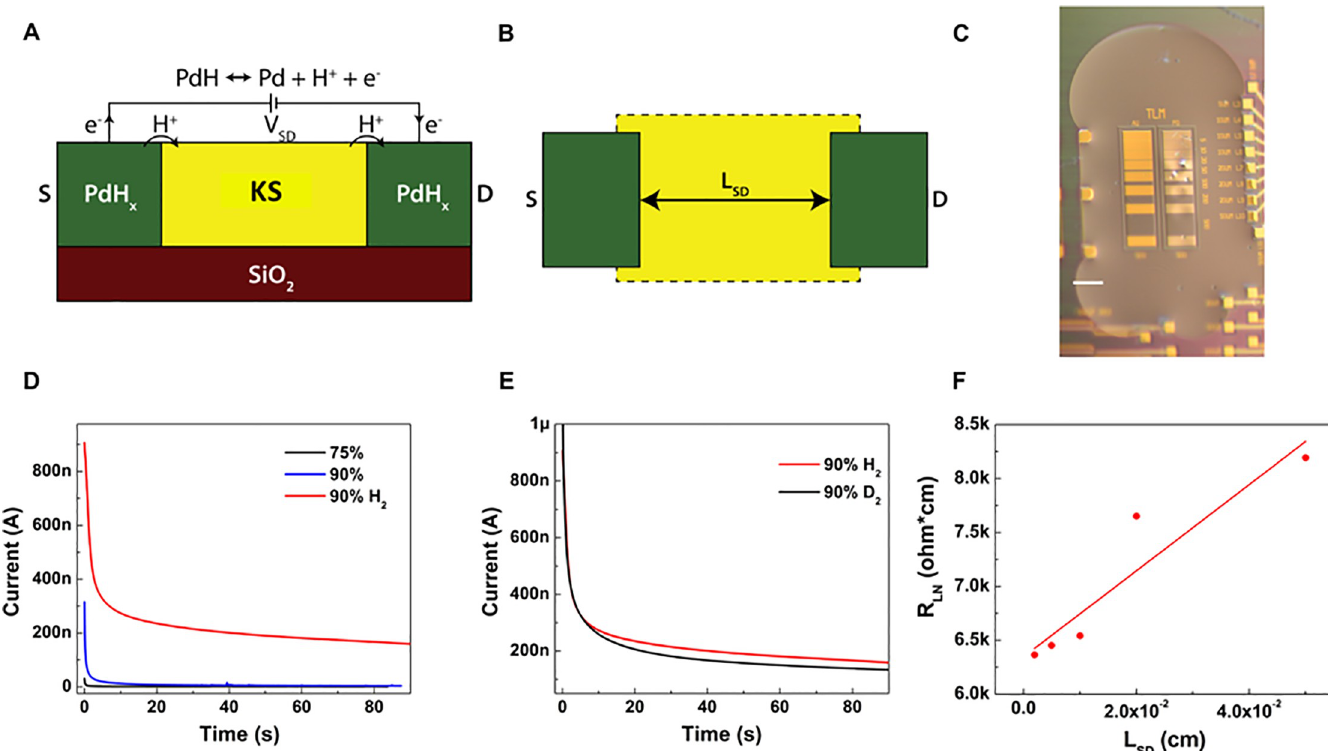
Fig 2. Proton conduction measurement of KS. A) Palladium hydride(PdH x ) electrode behavior. Under a V SD , PdH x source split into Pd, H + , and e − . Protons are injected into the KS, whereas electrons travel through external circuitry and are measured. B) TLM geometry. Varying the distance between source and drain (L SD ) distinguishes between the fixed PdH x − KS interface contact resistance and the varying bulk resistance. C) Optical image of TLM geometry with hydrated KS on the surface. Scale bar, 500 μ m. D) Transient response to a 1V bias in KS at 75%, 90%, 90% H 2 RH, in which the current under 90% with hydrogen is much higher than that under 90% RH without hydrogen. E) Deuterium current (black) at 90% D 2 humidity is lower than proton current (red). F) The normalized resistance R LN as a function of L SD , A linear fit gives a bulk material proton conductivity of 0.50 ± 0.11 mS cm -1